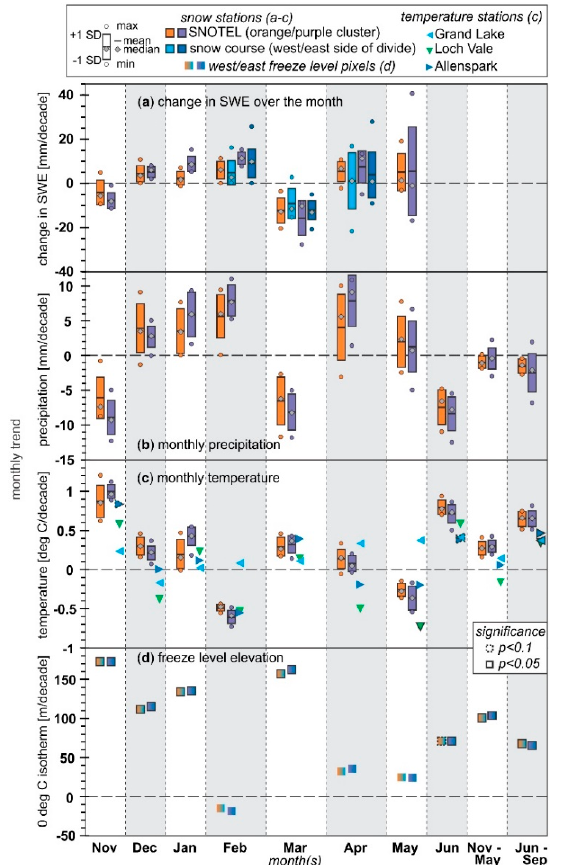
Figure 6. Distribution of monthly trends for each month of the snow season (November through May) for all Snowpack Telemetry (SNOTEL) stations (Clow [15]; orange and purple groups) for the period from 1981 to 2015, for ( a ) change in snow water equivalent (SWE) (includes snow courses, as per Figure 4); ( b ) precipitation; ( c ) temperature; and ( d ) elevation of freeze level or zero-degree isotherm (data from [56]). The freeze-level data were from 2.5° modeled pixels centered at 40° N latitude, with 107.5° W representing the west side of the study area and 105° W representing the east side. For the latter three figures, the season trends for winter from November through May and for summer from June through September are presented. The temperature trends for three non-SNOTEL weather stations are also presented in ( c ).